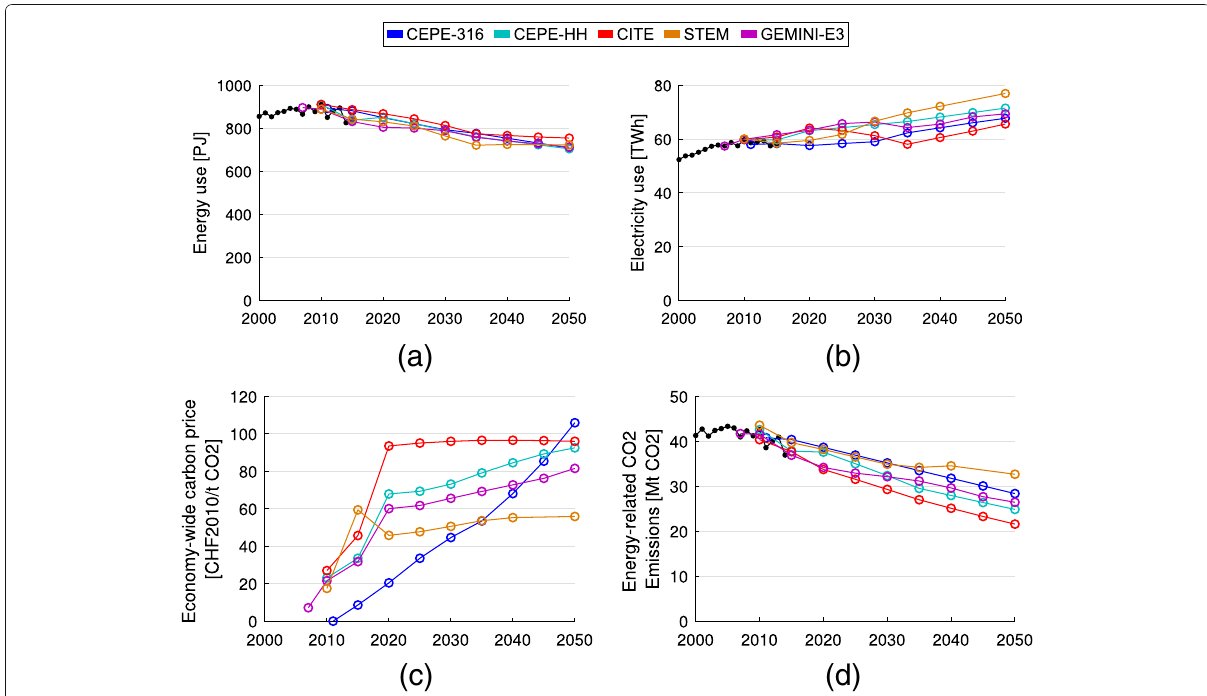
Fig. 1 BAU scenario. a Final energy use. b Electricity use. c Economy-wide carbon price. d Carbon